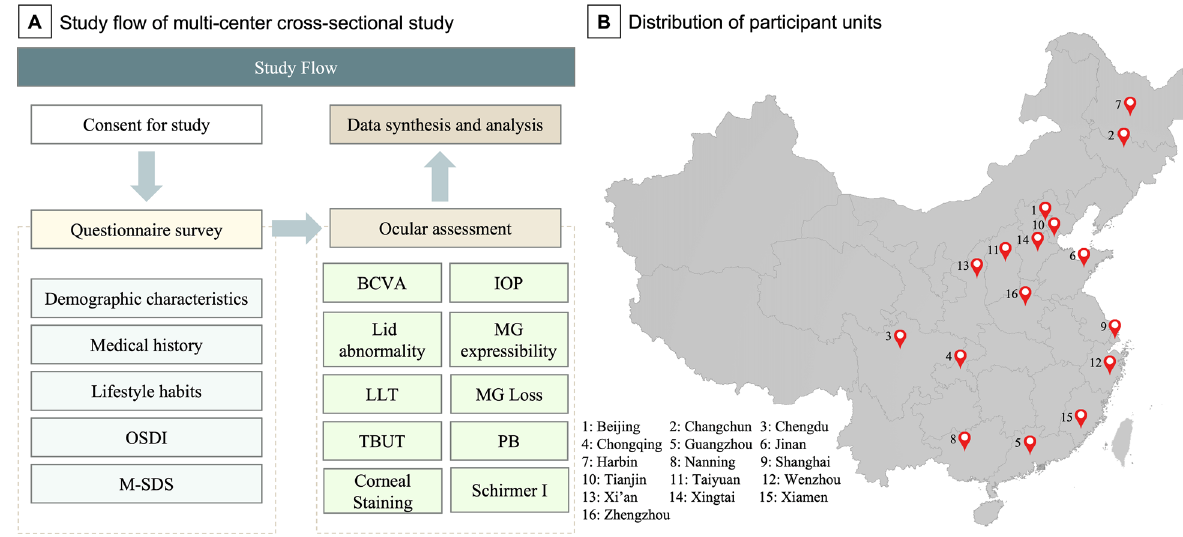
Figure 1. The study flow (Part A ) and the geographic distribution of 23 eye centers in 16 cities (Part B ). OSDI ocular surface disease index, M-SDS modified self-rating depression scale, BCVA best corrected visual acuity, IOP intraocular pressure, LLT lipid layer thickness, MG meibomian gland, TBUT tear film break-up time, PB partial blink. (The figure used with permission from co-author